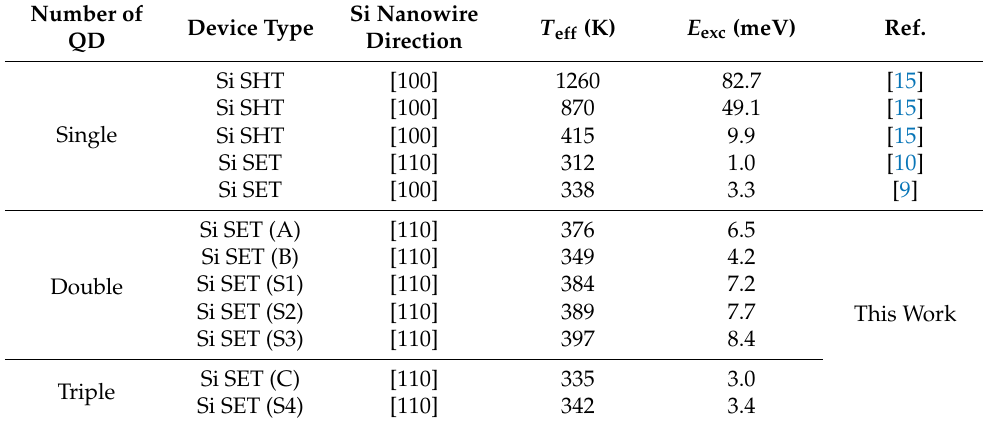
Table 1. Comparison of T eff and E exc for various CMOS-compatible Si SETs with different device configurations. Number of Device QD